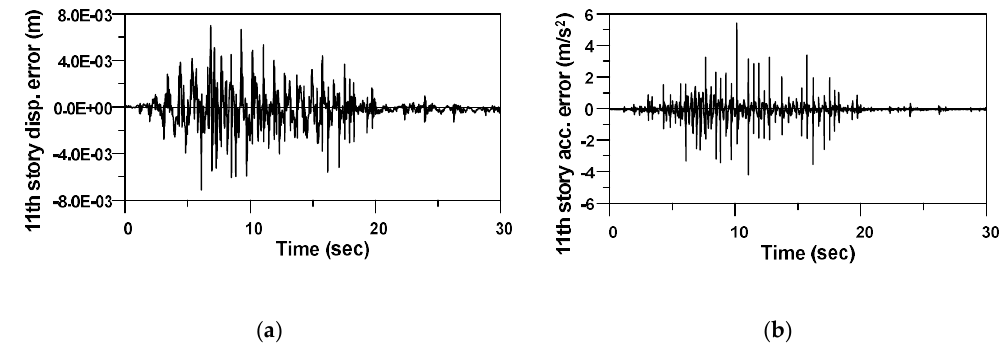
Figure 14. Response error time histories of Example 1 (EQ No. 11): ( a ) Displacement error time history; ( b ) Acceleration error time history.